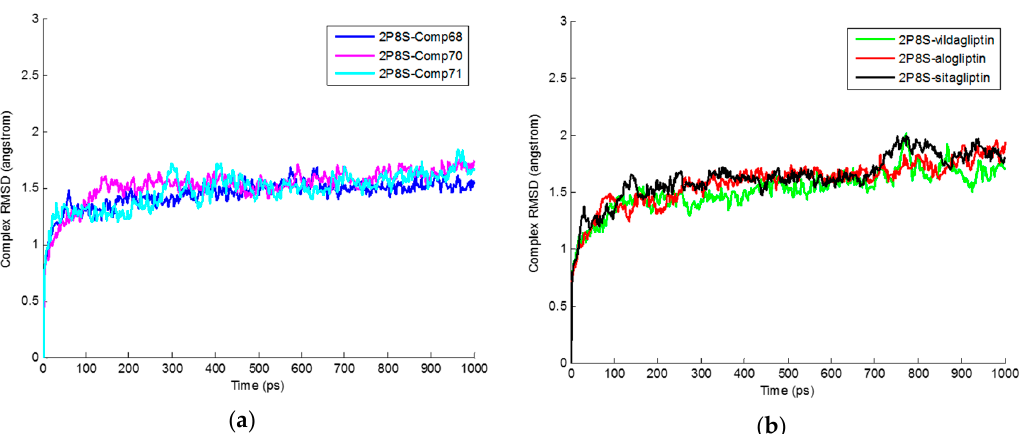
Figure 6. Root mean square deviations (RMSD) values of Protein ligand complexes all through molecular dynamics (MD) simulation at different time levels. ( a ) RMSD values of 2P8S_Comp68, 2P8S_Comp70, and 2P8S_Comp71 are present as blue, magenta, and cyan, respectively; ( b ) RMSD values of 2P8S_Vildagliptin, 2P8S_Alogliptin, and 2P8S_Sitagliptin are shown as green, red, and black, respectively.